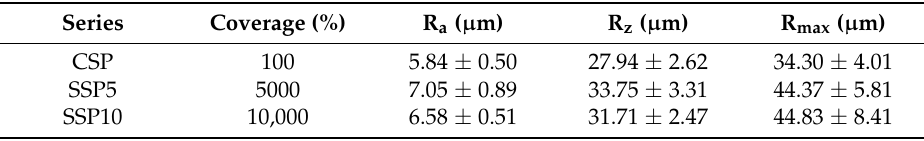
Table 2. Roughness values of samples submitted to different shot peening treatments.